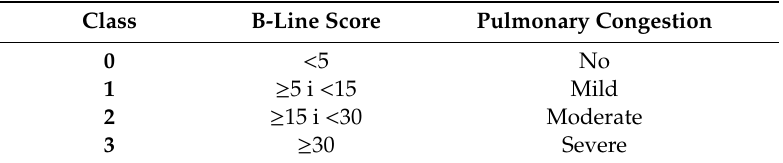
Table 4. Classification of pulmonary congestion based on lung ultrasound [20].